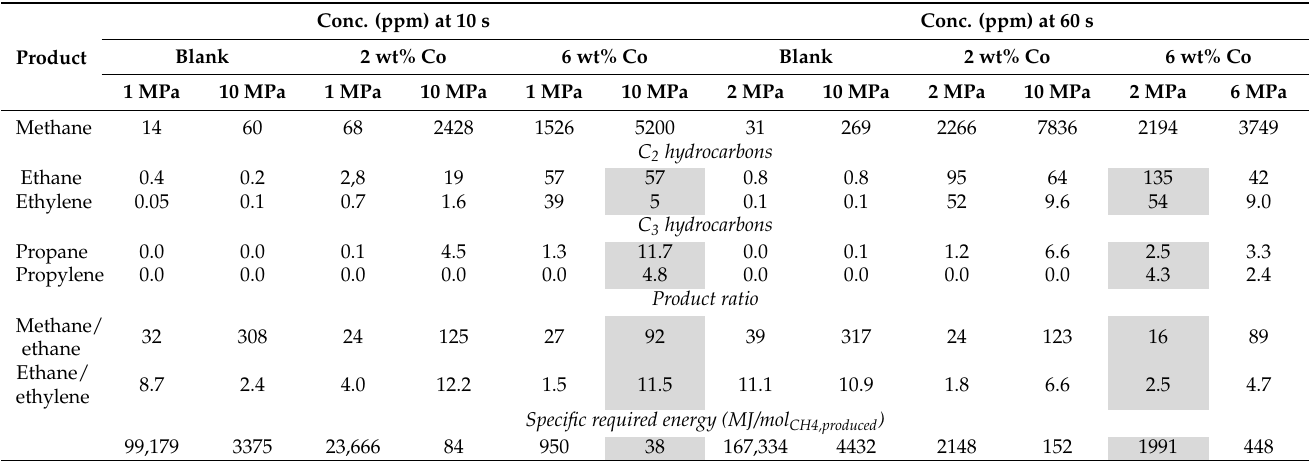
Table 2. Hydrocarbon concentrations and specific required energy (SRE) values for the blank, 2 and 6 wt% Co catalyst systems investigated for the pressure variation study at discharge times of 10 and 60 s. (Syngas (H 2 /CO) ratio: 2.2:1; current: 350 mA; inter-electrode gap: 1 mm; wall temperature: 25 ◦ C; expanded experimental hydrocarbon concentration uncertainty: ±